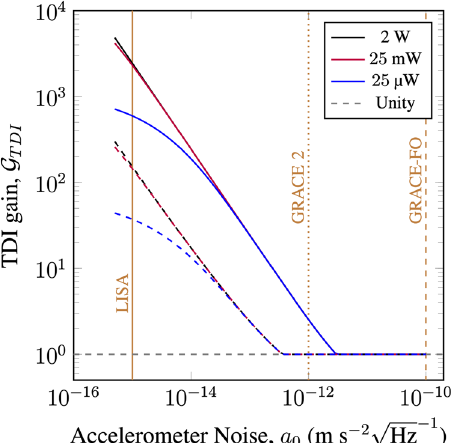
Fig. 4 Point mass sensitivity enhancement due to TDI. Plotted is the TDI gain as a function of accelerometer instrument noise for the two different laser phase noise performances, the GRACE-FO laser ffiffiffiffiffiffi p (cid:3) 1 Hz ) and phase noise requirement, Eq. (4) (solid lines, x c ¼ 8nm the actual laser phase noise performance, Eq. (5) (dashed lines, x T = 1 × 10 − 15 ). The TDI gain increases with decreasing accelerometer instrument noise as at lower accelerometer instrument noise levels the cancellation of the laser phase noise is more impactful. However, this does not increase inde fi nitely as eventually the quantum noise limit is reached. Three different quantum noise levels are consid- ered, corresponding to transmitted powers of 2 W, 25 mW and 25 = L = 200 km with a receiving μ W, at a satellite separation of L 12 23 aperture radius of 5 cm. The satellite orbital height is h = 500 km. The vertical dashed, dotted and solid brown lines show the projected accelerometer instrument noise for the GRACE-FO mission, the next GRACE mission (GRACE 2) and the LISA mission respectively. At large accelerometer noises the TDI gain is never less than 1, because TDI is a non-destructive